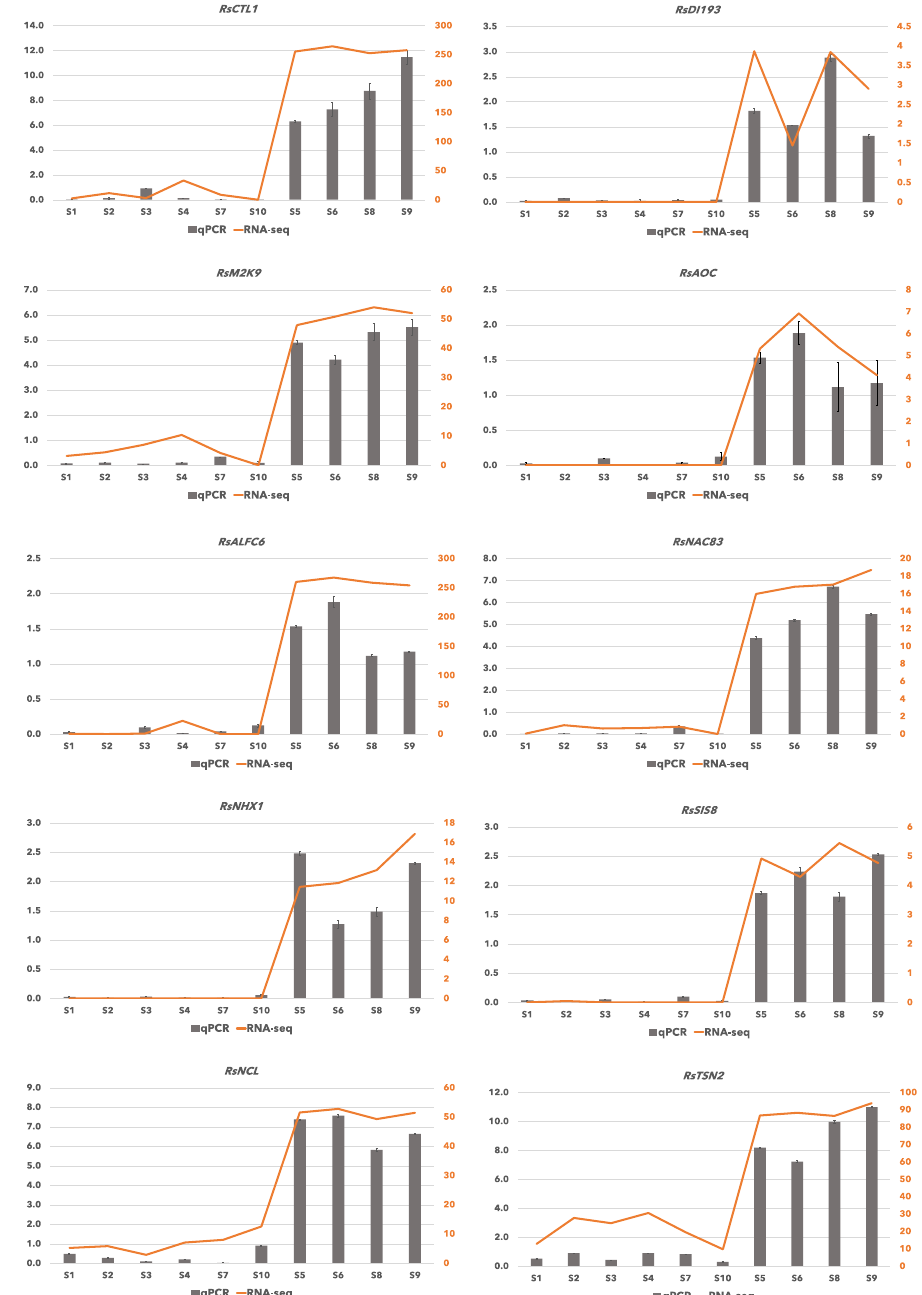
Figure 5. Verification of RNA-Seq results by real-time quantitative PCR. Log 2 value of the gene expression in oceanside/riverside for 10 selected genes. RNA-Seq results -log fold change (logFC)- are shown as bars and qRT-PCR results are shown as lines for relative gene expression [log 2 (Gene/ACT 2 )]. The 10 unigenes were named: RsCTL1 (homolog of AtCTL1 : Chitinase-like protein-1), RsDI193 (homolog of AtDI193 : Protein DEHYDRATION-INDUCED19-homolog-3), RsM2K9 (homolog of AtM2K9 : Mitogen-activated protein kinase kinase-9), RsAOC (homolog of OsAOC : Allene oxide cyclase), RsALFC6 (homolog of AtALFC6 : Fructose-bisphosphate aldolase-6), RsNAC83 (homolog of AtNAC83 : NAC domain-containing protein-83), RsNHX1 (homolog of AtNHX1 : Sodium/hydrogen exchanger-1), RsSIS8 (homolog of AtSIS8 : Probable serine/threonine-protein kinase-SIS8), RsNCL (homolog of AtNCL : Sodium/calcium exchanger NCL), and RsTSN2 (homolog of AtTSN2 : Ribonuclease TUDOR-2) (Table S32).